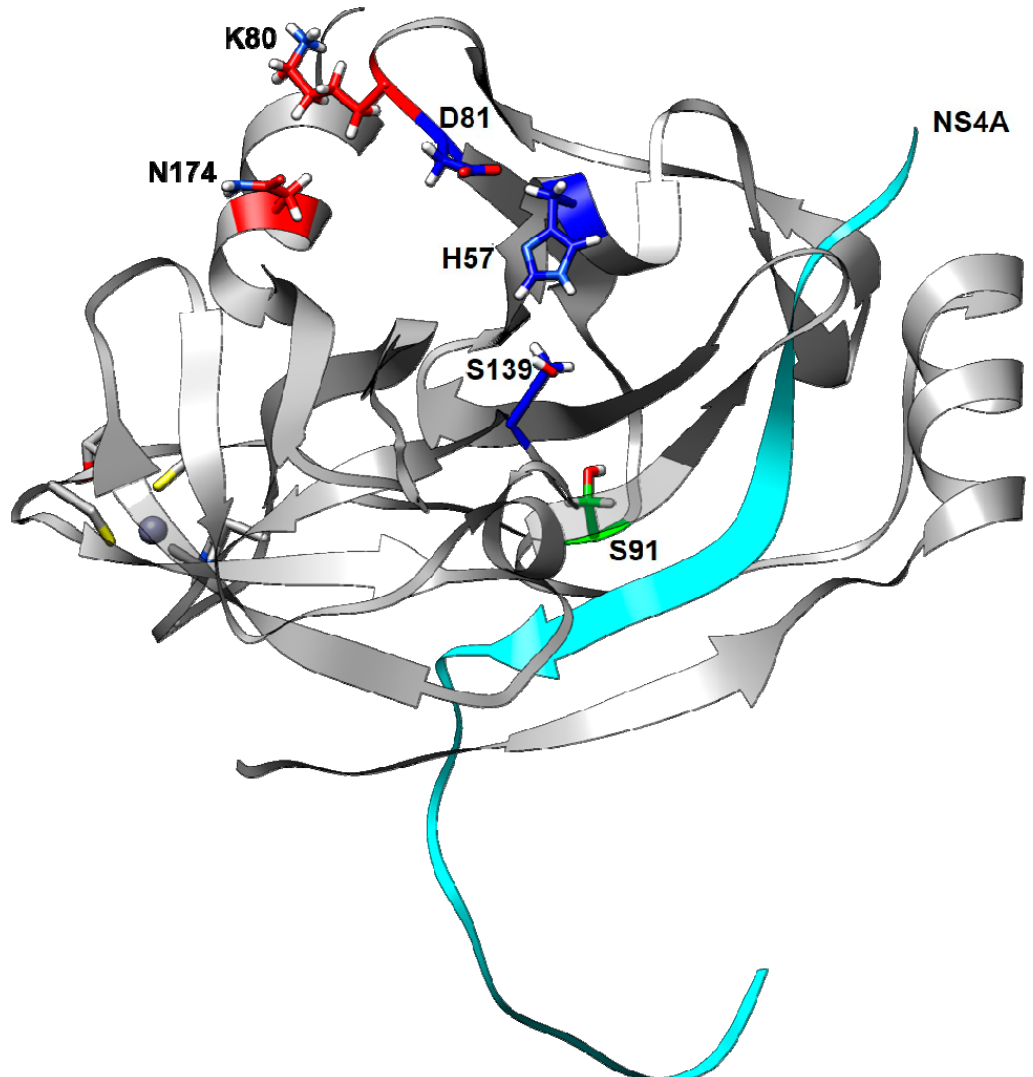
Figure 2. Three-dimensional structure of HCV NS3 protease based on the c1mutKSN sequence: positions 80 (red), 174 (red), 91 (green); the catalytic residues 57, 81, and 139 (blue); and the cofactor NS4A (cyan) are highlighted. Residue 80 is proximal to residue 174, but distant from residue 91.